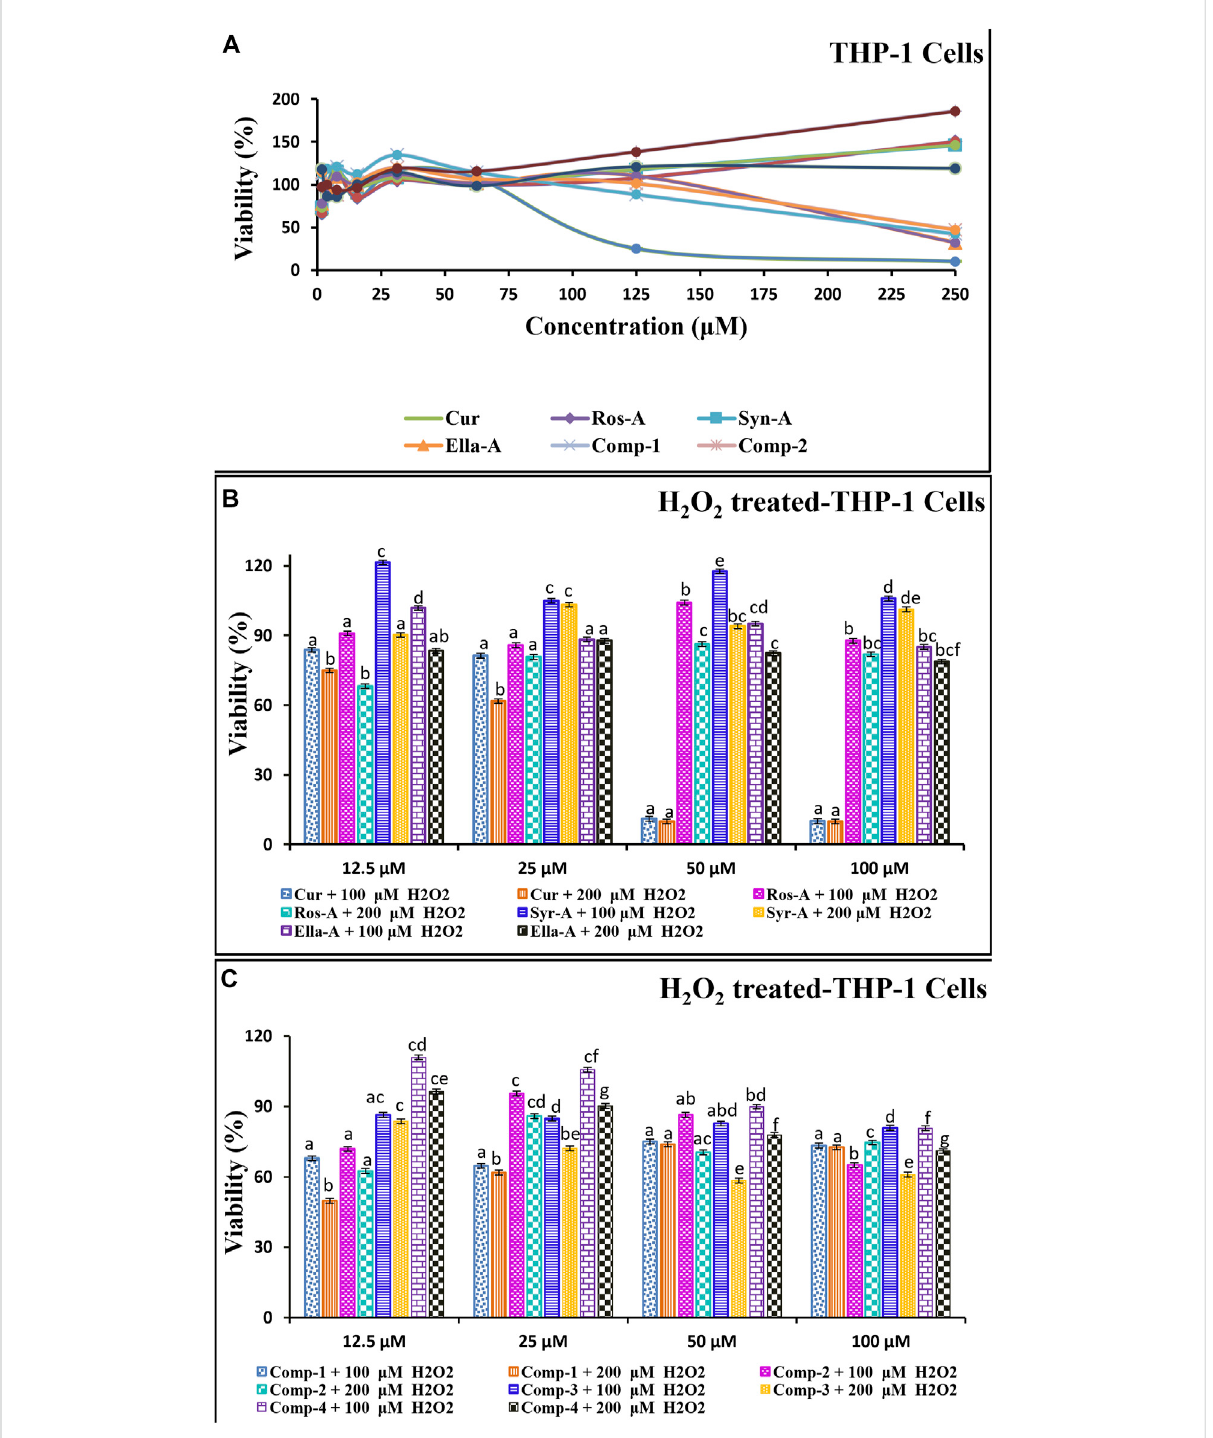
FIGURE 1 The in vitro cytotoxic/Cytoprotective effect of natural molecules and modes of compositions on the monocytes THP-1 Cells as well as against onH 2 O 2 -inducedcytotoxicityinTHP-1cellsusingMTTassay.TheTHP-1cells(5×10 5 )wereincubatedwithMolecules(Cur,Ros-A,Ella-A,Syr-A,and Syn-A) (12.5 – 100 μ M) or Compositions (Comp-1, Comp-2, Comp-3, Comp-4) with (B,C) or without H 2 O 2 (100 or 200 μ M) for 48 h (A) . The cytotoxicity testwasexpressedby%ofViability andData presented asmean ±SD( n ˃ 3).Different letters indicatesigni fi cantdifferencesamong treatment at p <